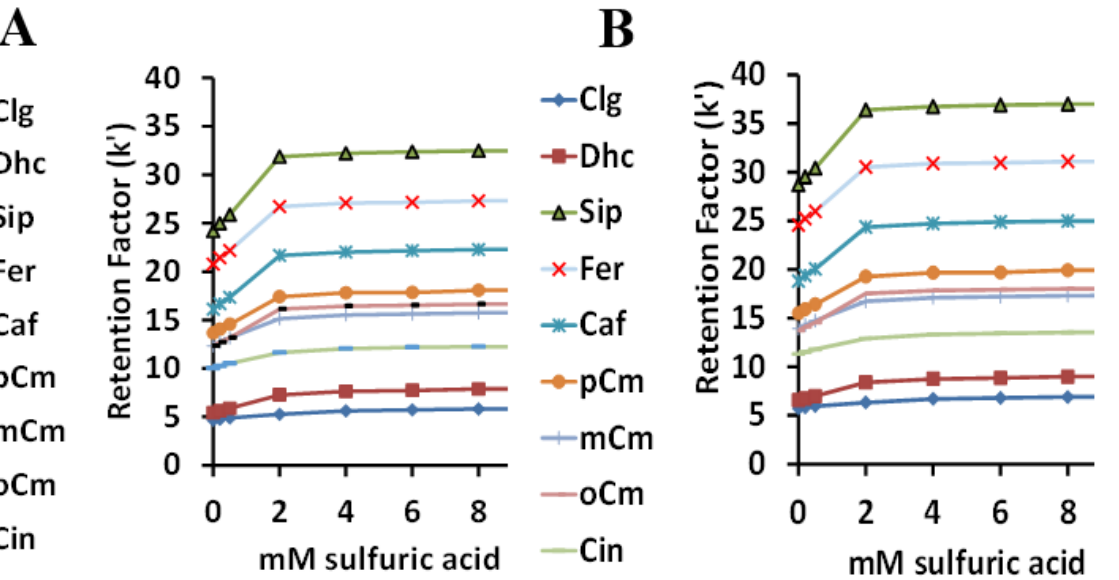
Figure 5. The relationship between the retention factor (k) and the sulfuric acid concentration using Tween 20 ( A ) and Tween 40 ( B ).